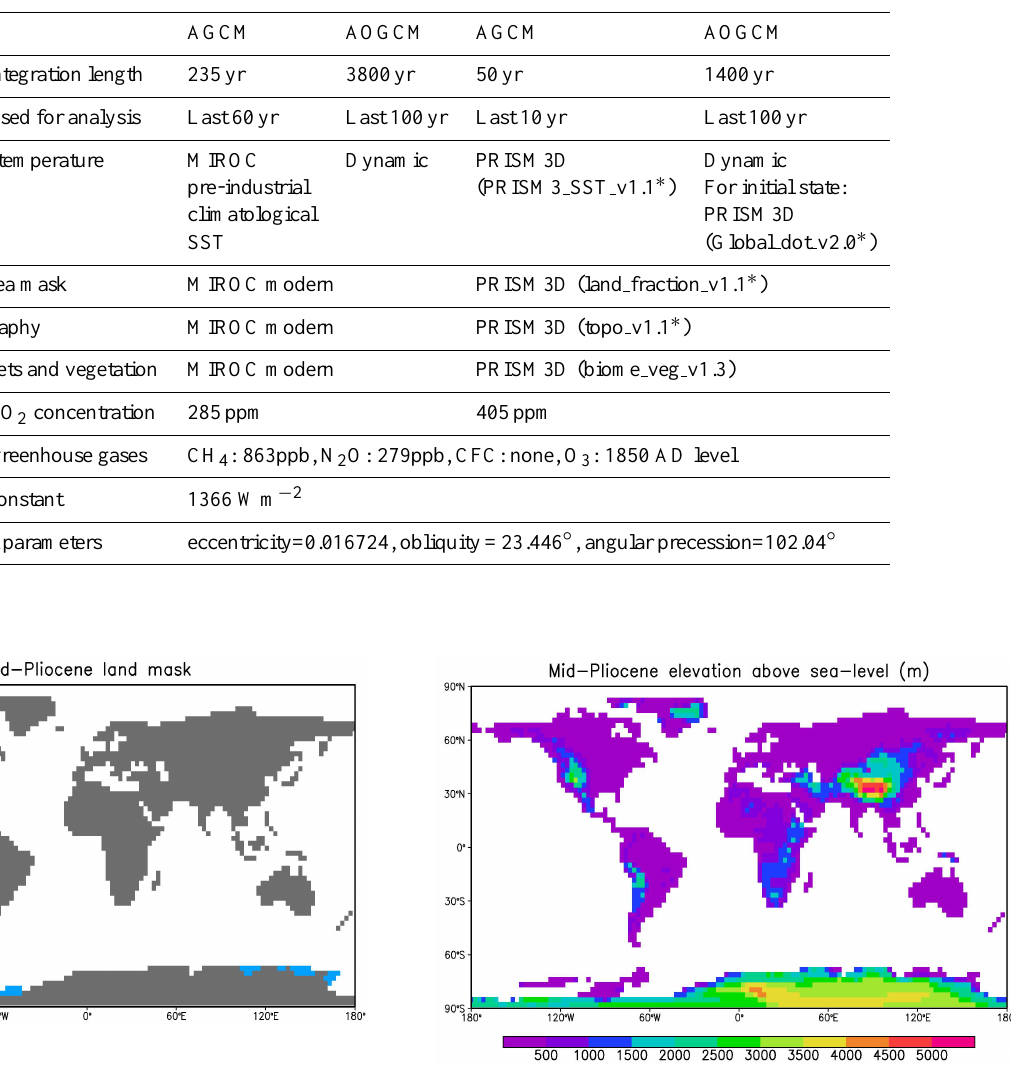
Fig. 1. Land sea mask used for the mid-Pliocene. The blue grid cells represent areas which are ocean in the mid-Pliocene but are land in present day. Conversely, the brown grid cells represent areas which are land in the mid-Pliocene but are ocean (namely, the Hudson Bay) in present day.